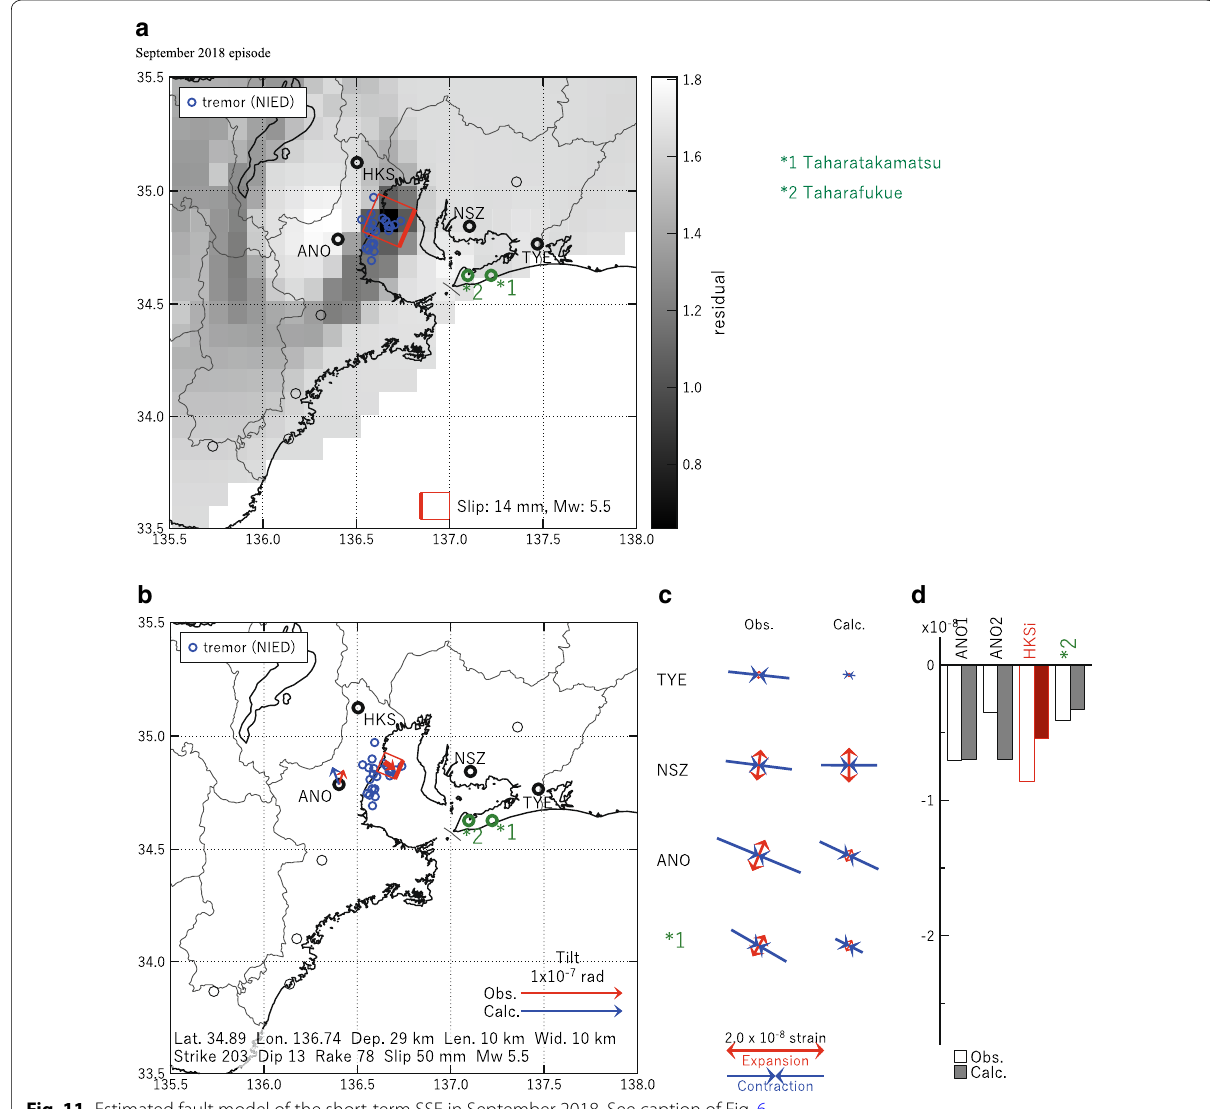
Fig. 11 Estimated fault model of the short-term SSE in September 2018. See caption of Fig.